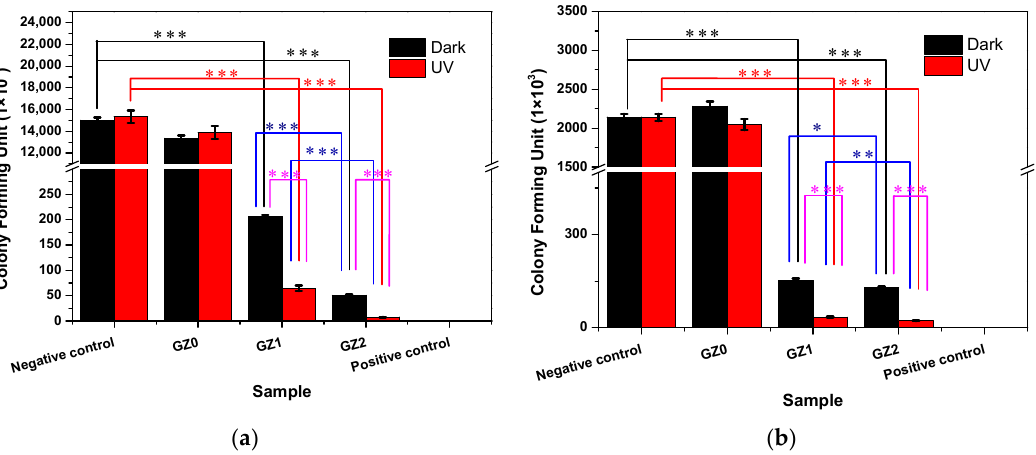
Figure 10. The antibacterial activity of the gelatin/ZnO fibers against ( a ) Staphylococcus aureus and ( b ) Escherichia coli with and without UV light. (* represents p < 0.05, ** represents p < 0.01 and *** represents p < 0.001.)